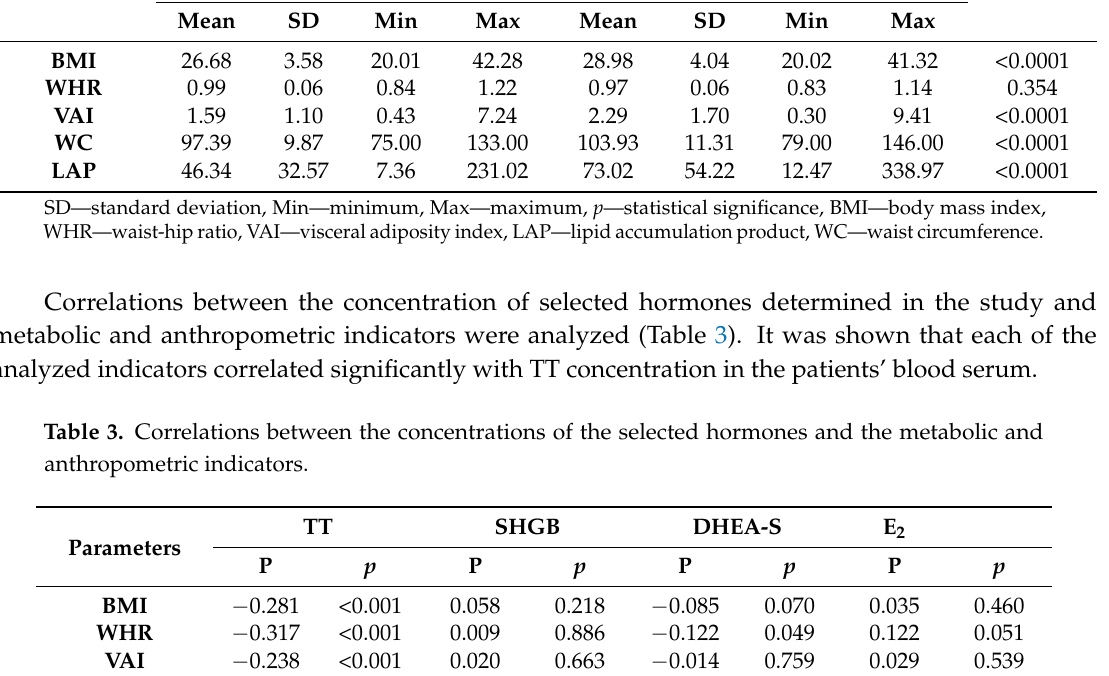
Table 2. Indicators of obesity and fat accumulation in the studied men vs testosterone concentration. Men without Testosterone Deficiency Syndrome ( n = 273) Parameters